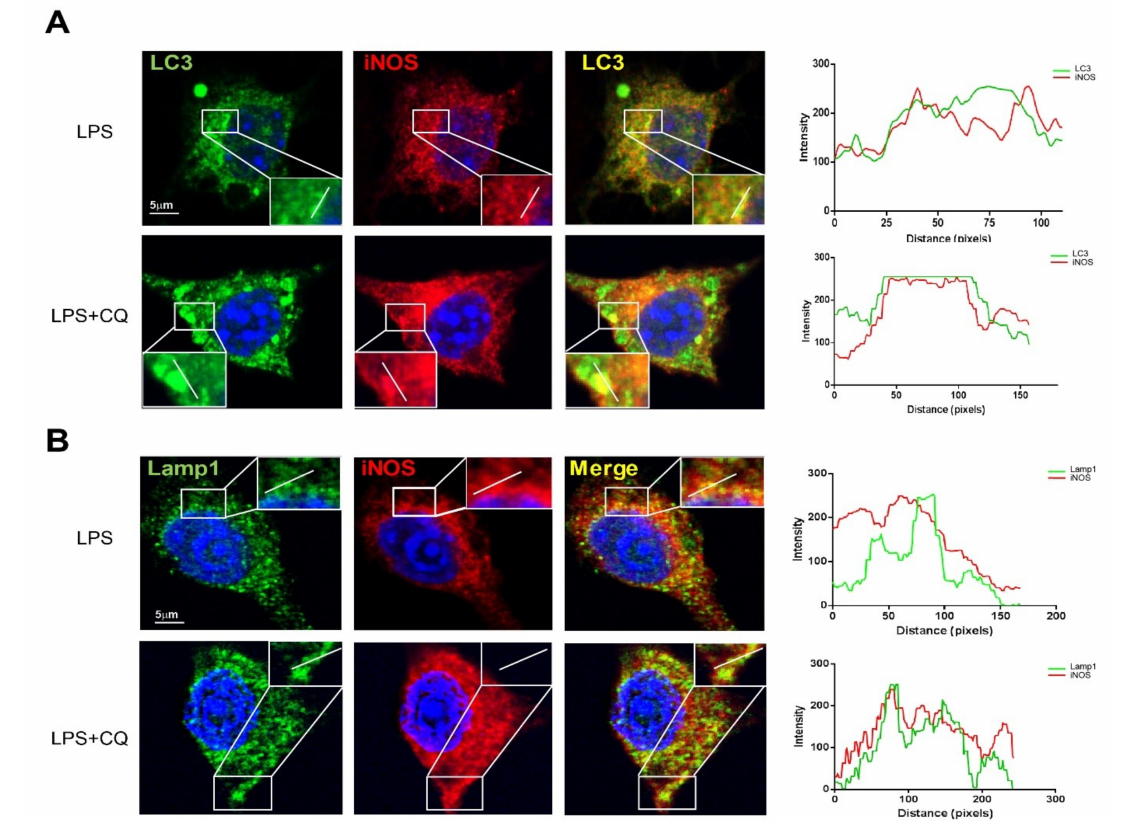
Figure 4. iNOS co-localizes with autophagosome and lysosome. ( A ) Raw 264.7 cells were treated with LPS (1 µ g / mL) 12 h, followed by removing LPS and add CQ (30 µ M) for another 12 h. CTRL group is blank control group with DMSO treatment. The confocal images of cells which were stained with anti-iNOS and anti-LC3. CTRL group is blank control group with DMSO treatment ( B ) Raw 264.7 cells were treated with LPS (1 µ g / mL) 12 h, followed by removing LPS and add CQ (30 µ M) for another 12 h. CTRL group is blank control group with DMSO treatment. The confocal images of cells which stained with anti-iNOS and anti-LAMP1 were captured by Leica microsystem. The results of co-localization were analyzed by Leica Application Suite X software and GraphPad